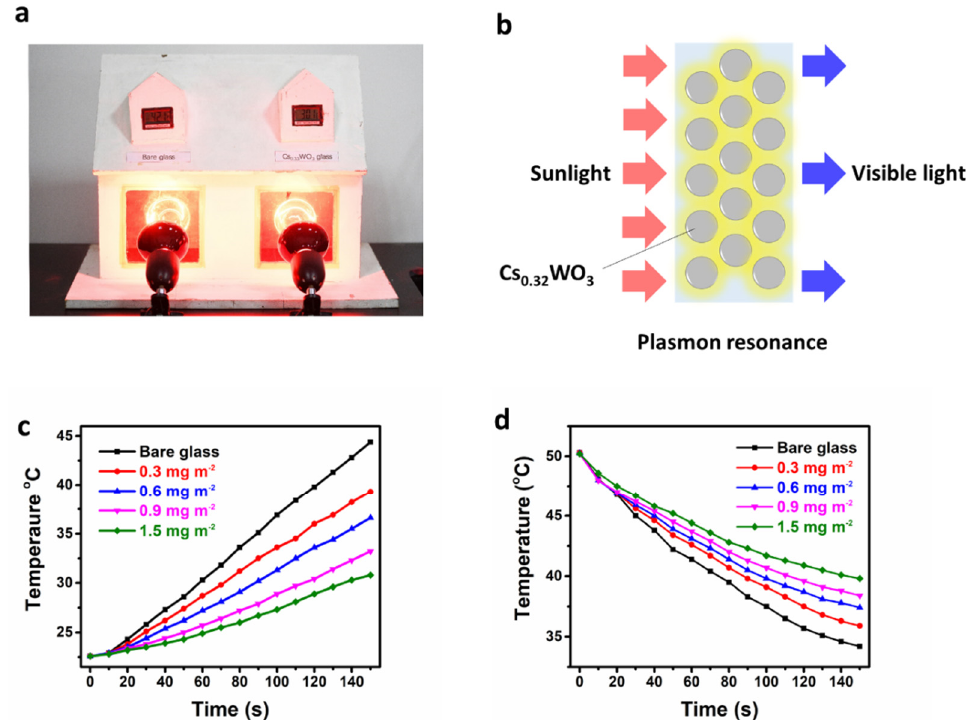
Figure 6. Heat insulation effect of Cs 0.33 WO 3 /PUA composite coatings: ( a ) photograph of a model, ( b ) heat insulation mechanism of Cs 0.33 WO 3 /PUA composite coating, ( c ) heating curve, and ( d ) cooling curve of model Cs 0.33 WO 3 /PUA composite coating with varying Cs 0.33 WO 3 concentration.